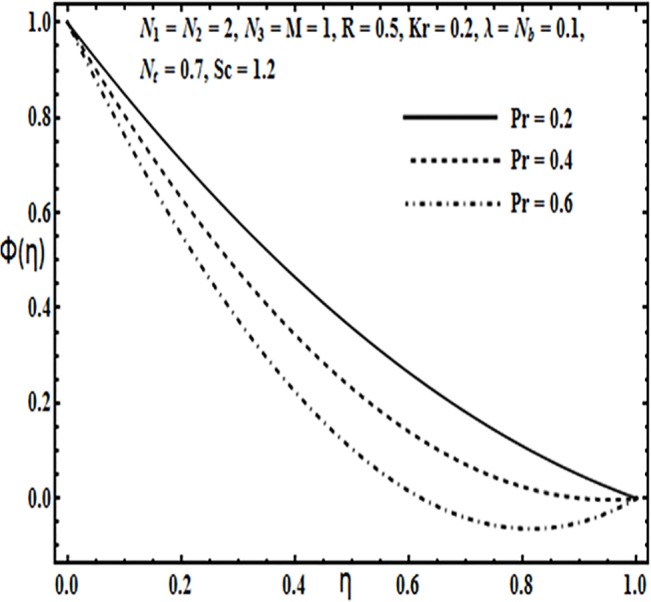
Effect of Pr on ϕ(η).